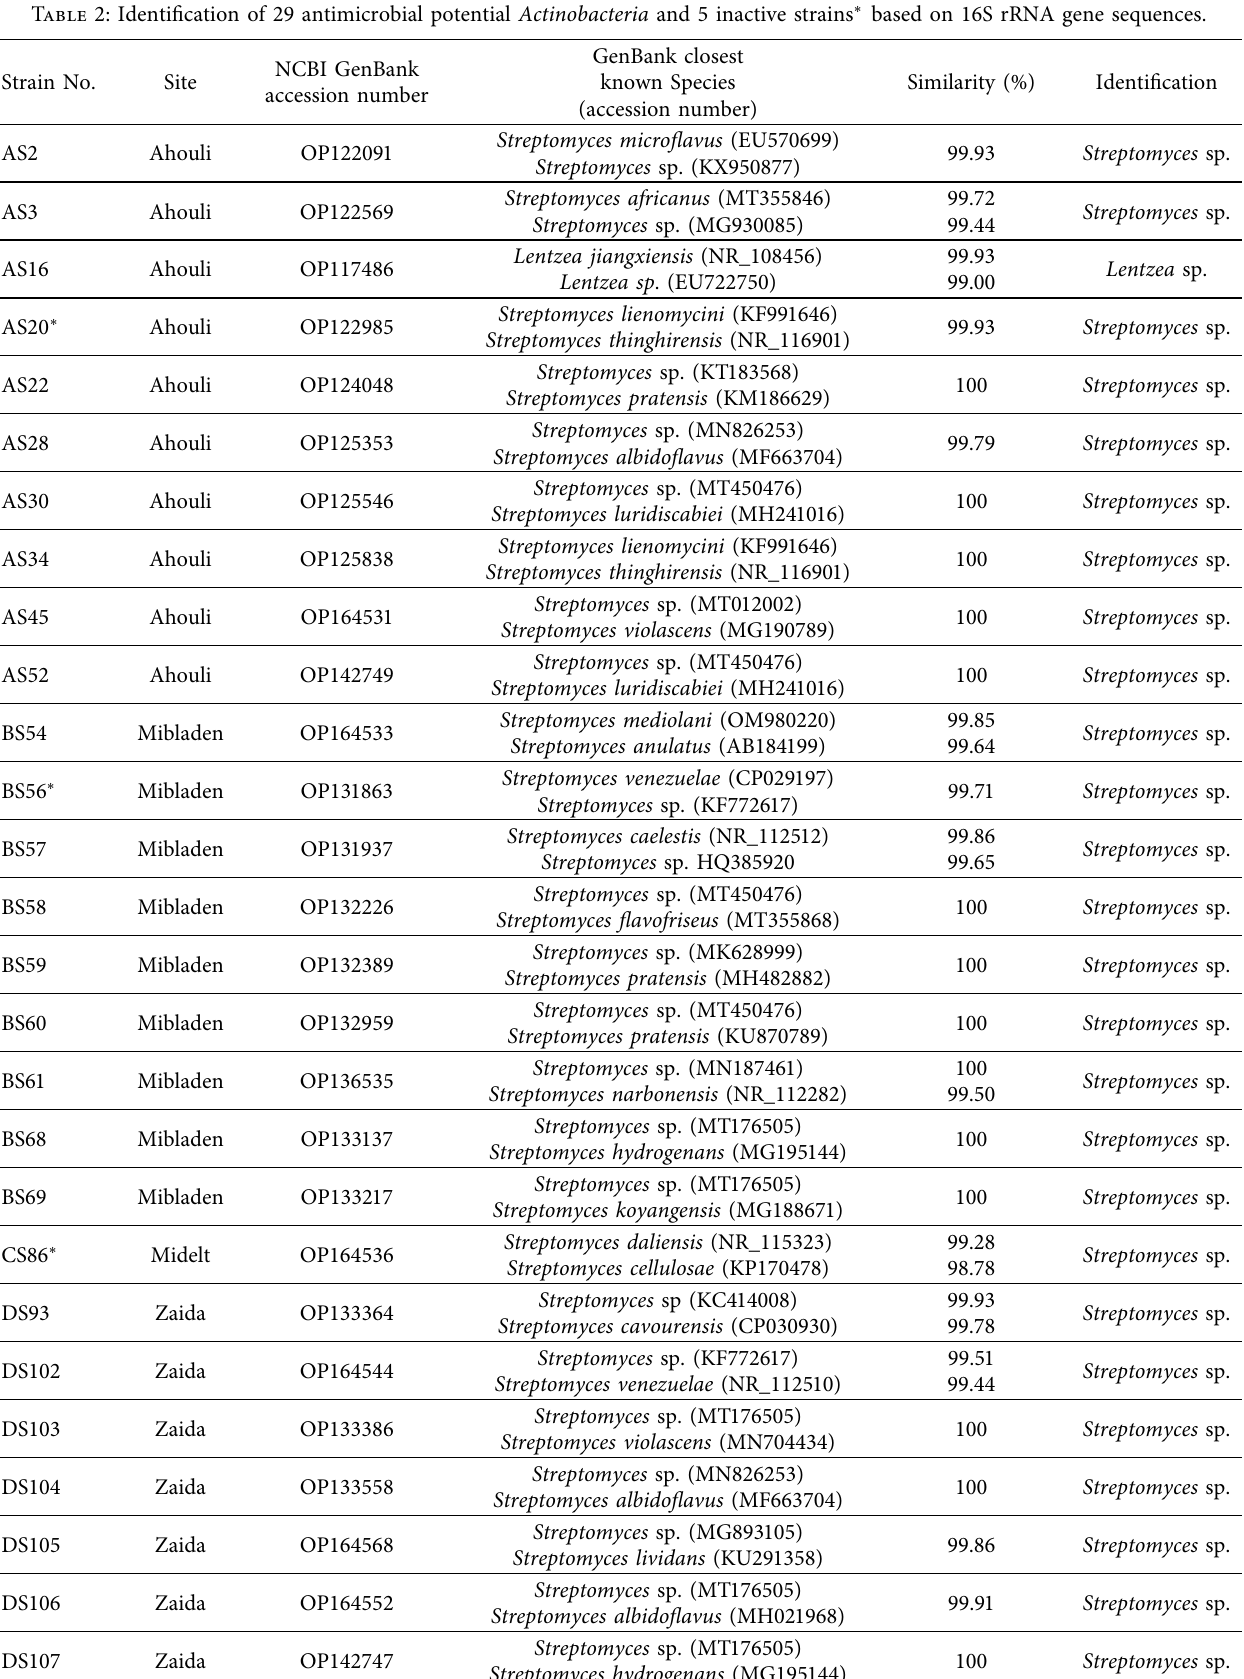
Table 2: Identifcation of 29 antimicrobial potential Actinobacteria and 5 inactive strains ∗ based on 16S rRNA gene sequences. Strain